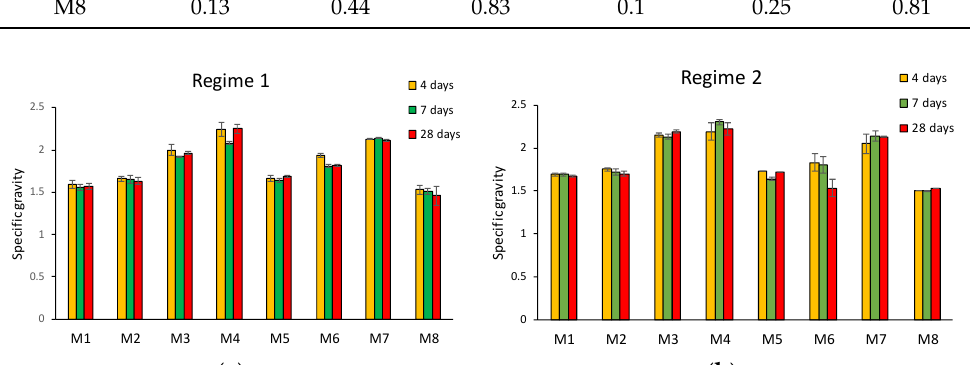
Figure 1. Specific gravity of the AAC over time after curing under: ( a ) Regime 1 and ( b ) Regime 2. Table 2. Mix design of the AAC compositions. The rate of strength development, as depicted in Table 2, shows that the mixes M5, M6, and M8 cured in both Regimes 1 and 2, as well as M3 cured in Regime 1, and M4 and Mix Design, % wt. W/S Ratio M7 cured in Regime 2 had gradual strength development throughout the 28 days study period.